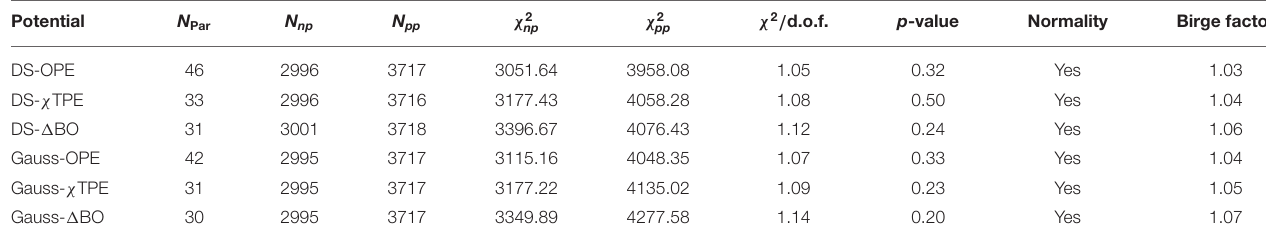
TABLE 7 | Granada potentials